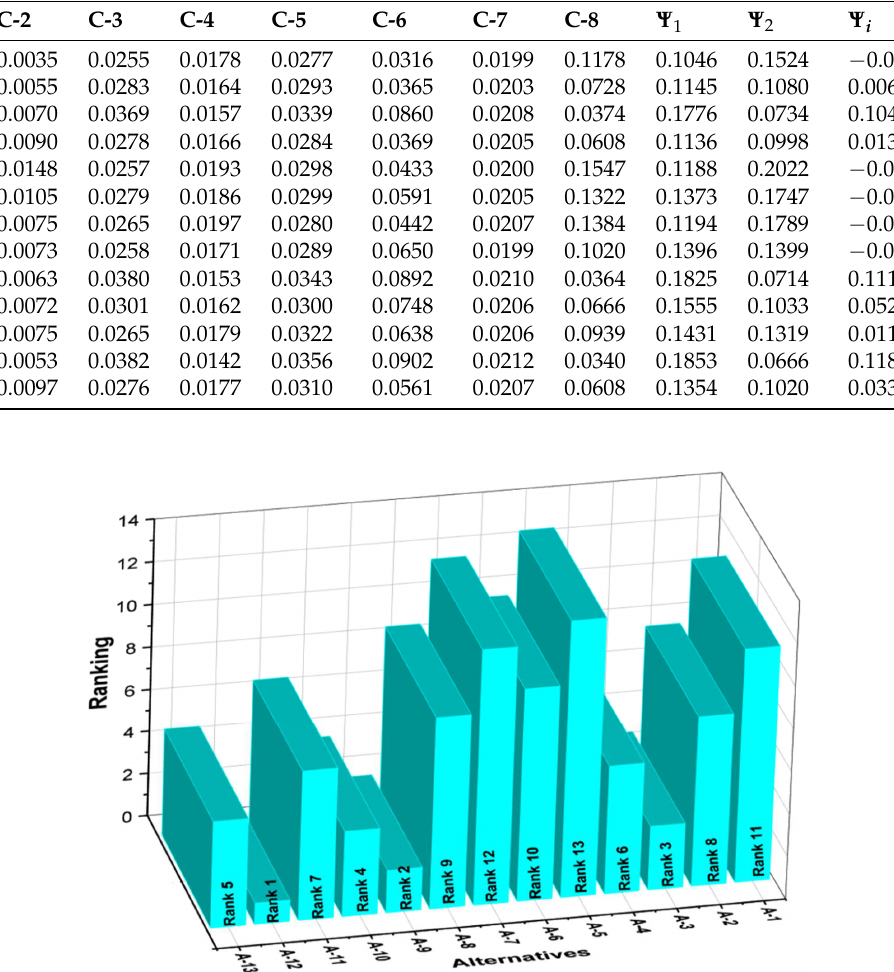
Table 6. Weighted matrix and ranking of alternatives.